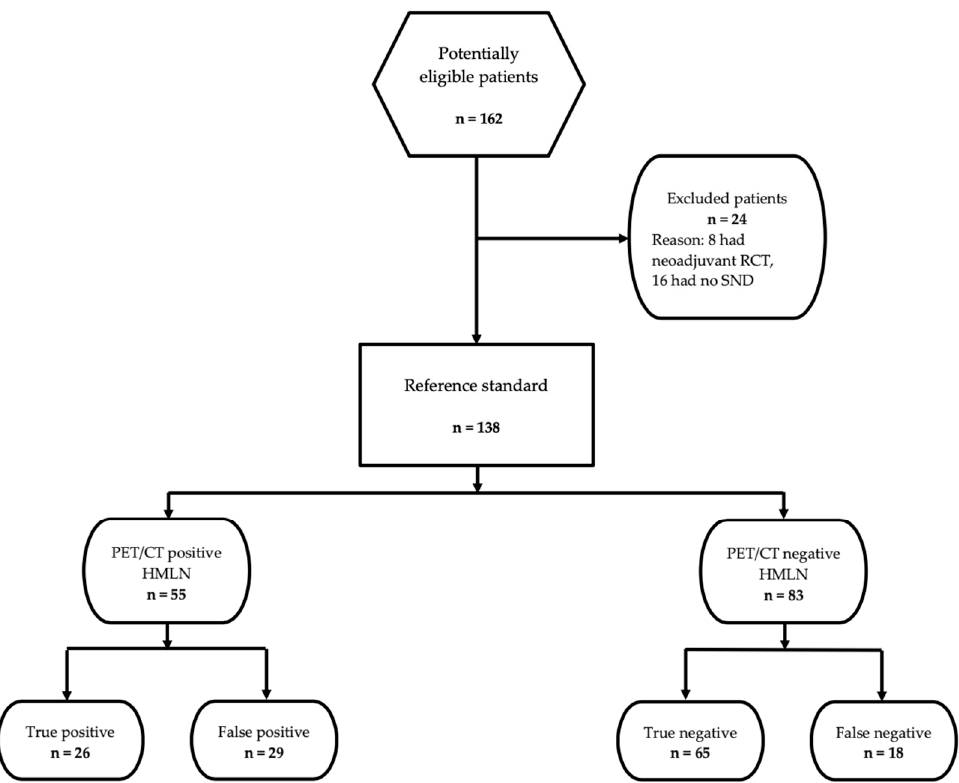
Figure 1. STARD flow diagram illustrating patient enrollment at study entry. PET: positron emission tomography; SND: systematic lymph node dissection; RCT: radiochemotherapy. Table 1. Characteristics of patients and tumors ( n = 138). RUL: right upper lobe, RML: right middle lobe, RLL: right lower lobe, LUL: left upper lobe, LLL: left lower lobe, SD: standard